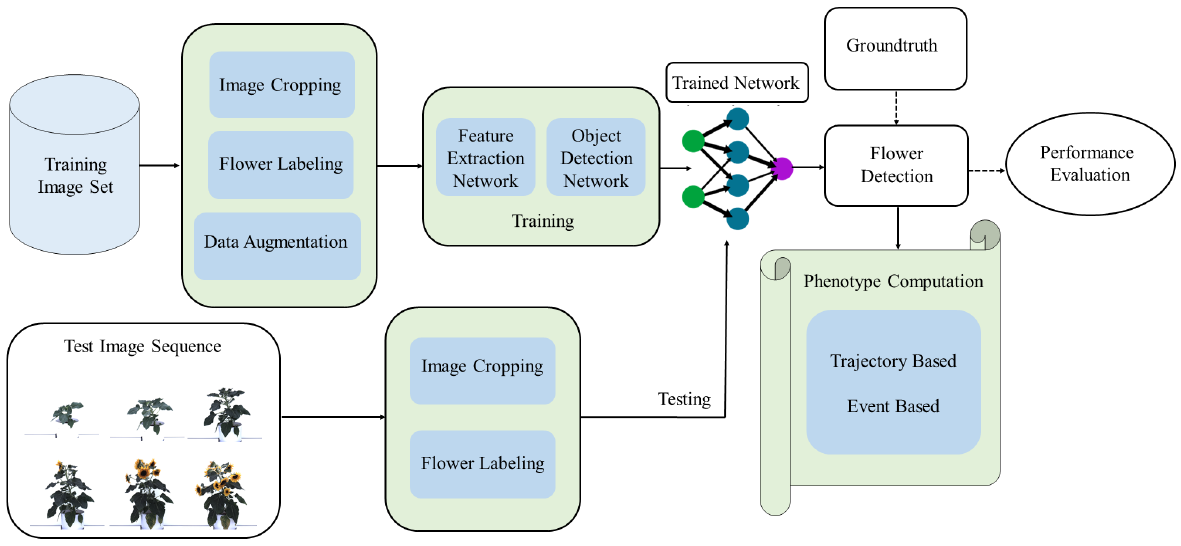
Figure 2. Block diagram of